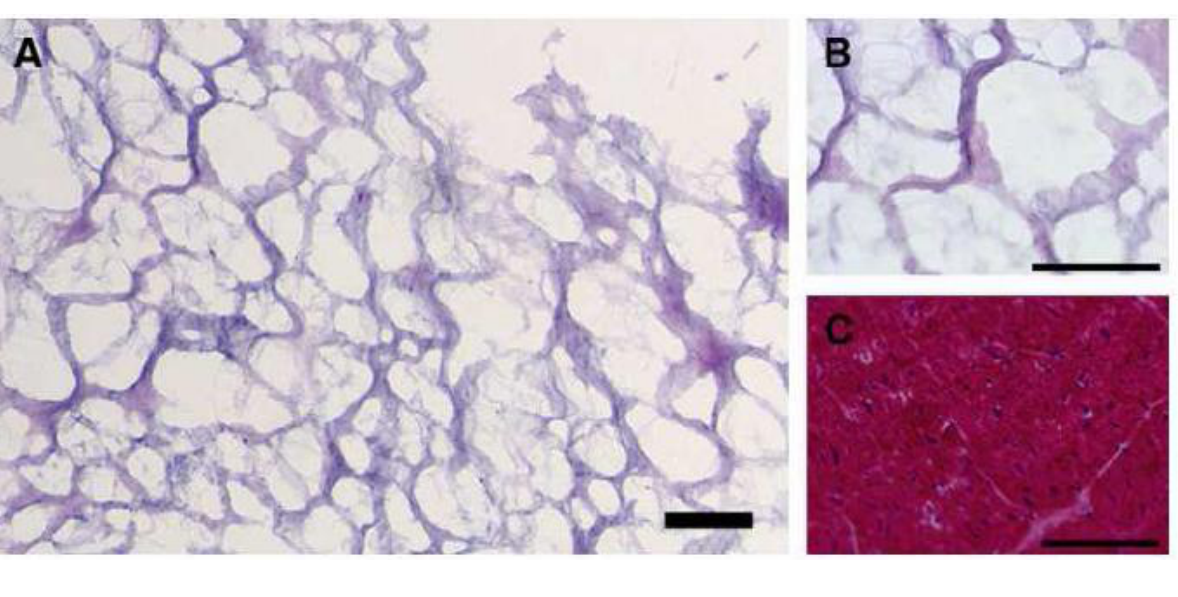
Figure 4. Decellularized heart matrix by H&E staining: ( A ) intact acellular matrix before lyophilization, a porous structure can be clearly seen; ( B ) acellular matrix before being milled; ( C ) normal heart tissue before decellularization [22]. Scale bars are 100